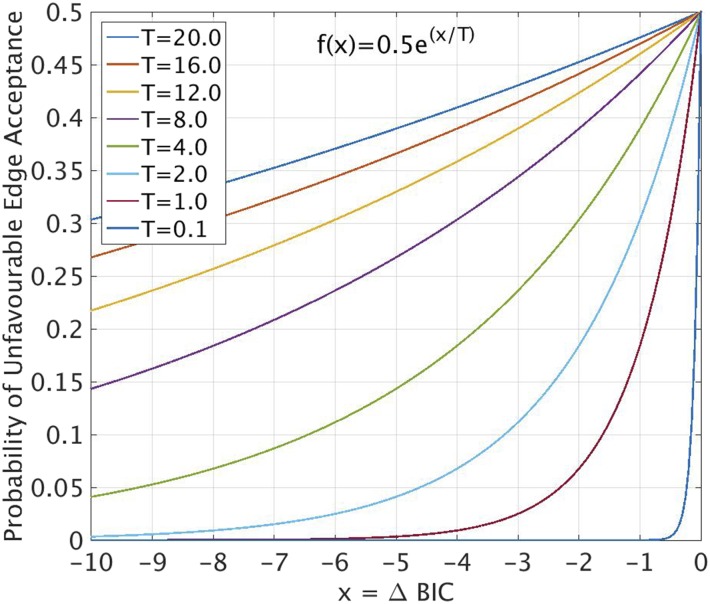
Acceptance criterion for edges that are unfavorable to BIC score during simulated annealing stage of structure learning. Representative temperatures in the range 0.1≤T≤20 plotted.